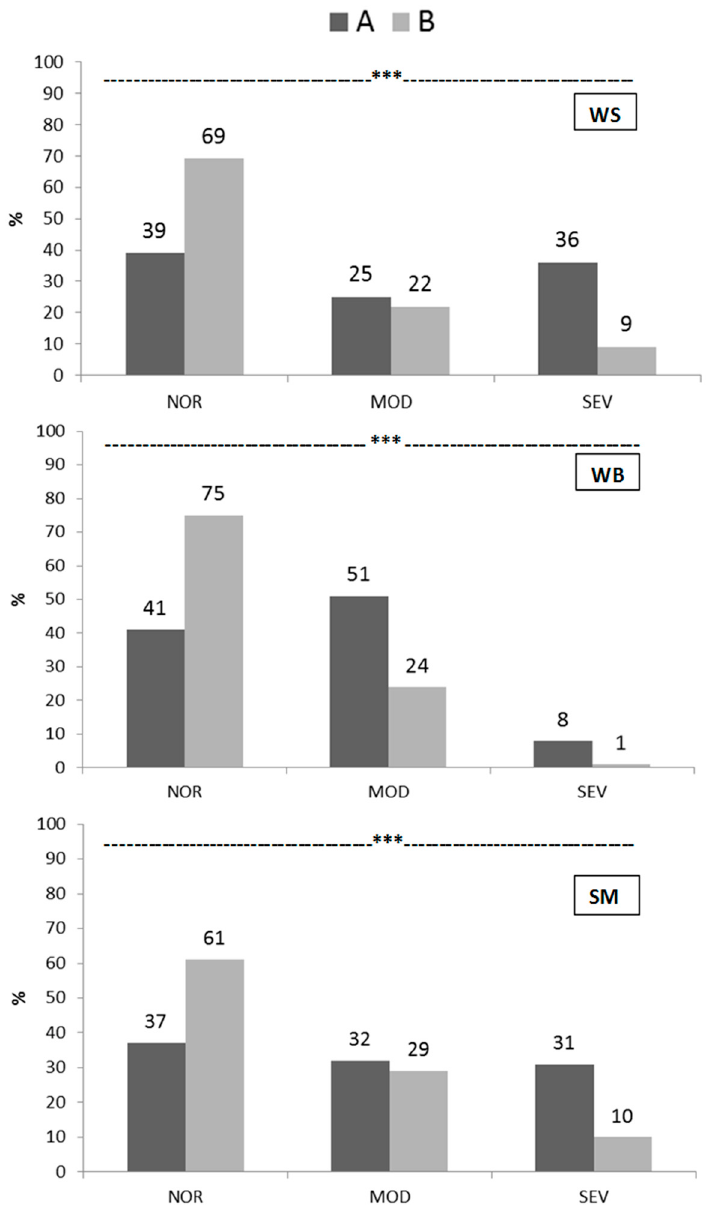
Figure 1. Incidence (%) and severity (no lesions (NOR), moderate lesions (MOD) and severe lesions (SEV)) of white striping (WS), wooden breast (WB) and spaghetti meat (SM) defects in both genotypes (A and B) at slaughtering (35 d) (*** p <